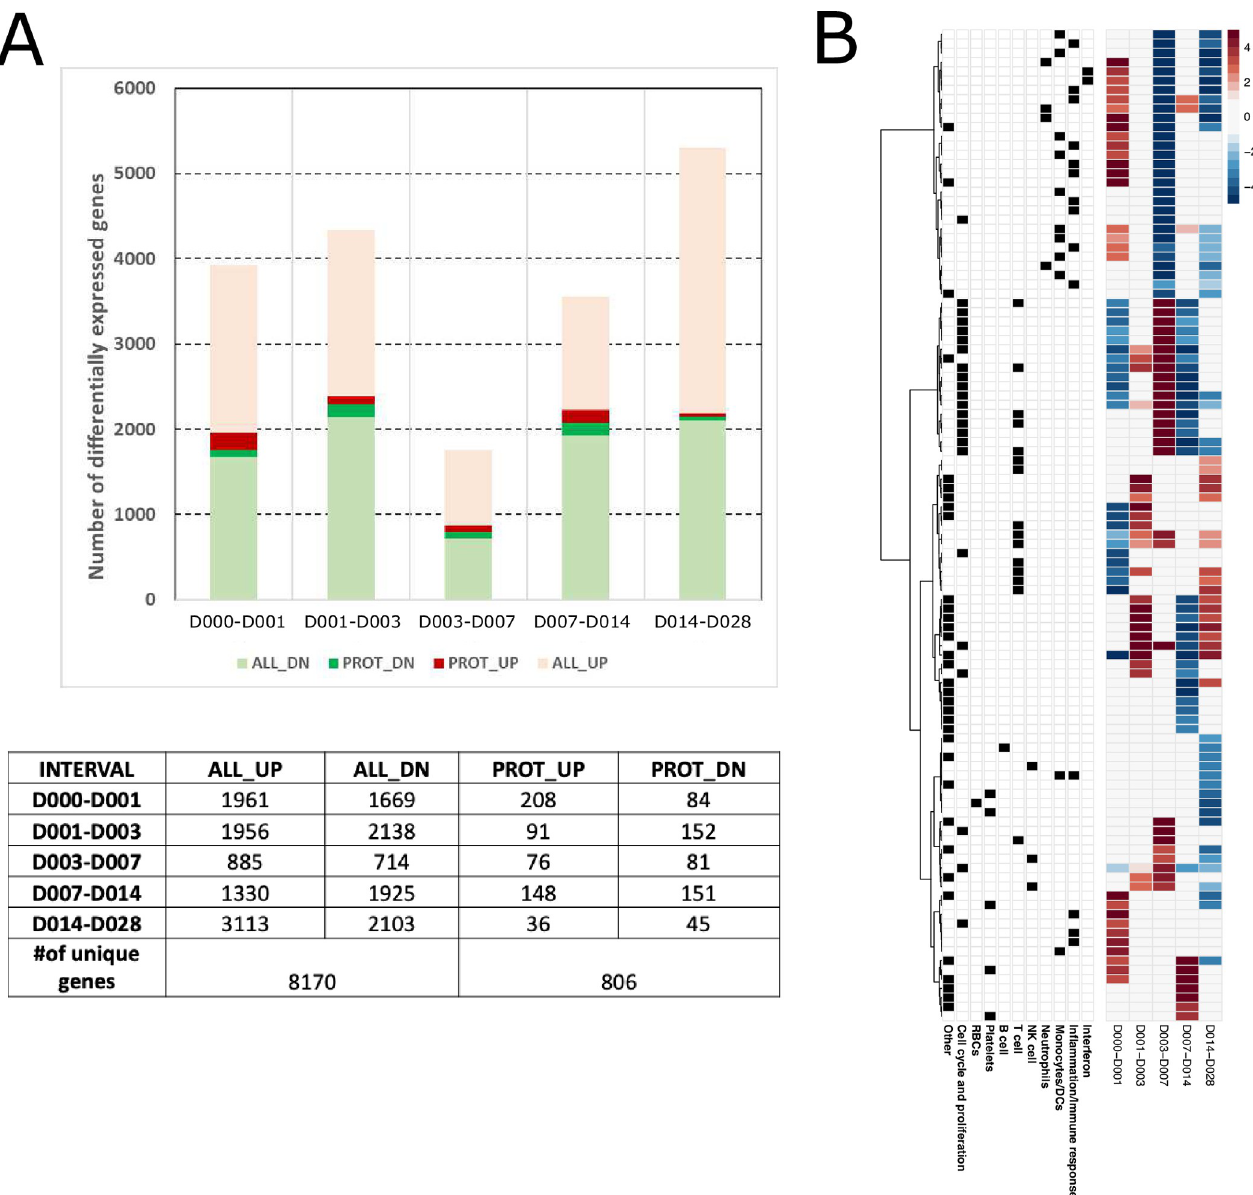
Fig 1. Vaccine induced gene responses after the first immunization. A. Barplot and table showing numbers of vaccine-induced genes, including the subset associated with protection with increased (light red, red) or decreased (light green, green) expression over each time interval in all immunized subjects (ALL_UP+PROT_UP, ALL_DN+PROT_DN) (FDR < 0.2, p < 0.05, 90% CI > 0 or < 0). Darker colors indicate genes that also differ significantly in expression between protected (P) and non-protected (NP) subjects (PROT_UP, PROT_DN). B. Heatmap of modules significantly enriched for vaccine-induced genes. Each row represents a BTM, each column represents a time interval. Heatmap color shows hypergeometric effect size (ES) of a BTM enriched in genes with increased (red/positive ES) or decreased (blue/negative ES) expression. Non-significant BTMs are shown in white. Assignment of a BTM to a high-level annotation group is indicated by a black square in the corresponding annotation row on the left. total, P_1 and NP_1 have 317 genes in common (hypergeometric p = 4.2e-17) (Fig 2E), although numbers of enriched modules and gene expression dynamics are distinct (S3A, S3B and S3C Fig). Expression of most genes in these clusters was increased over the interval D0-1, with higher response magnitude in NP_1 (S3C Fig). Consistent with strong enrichment of